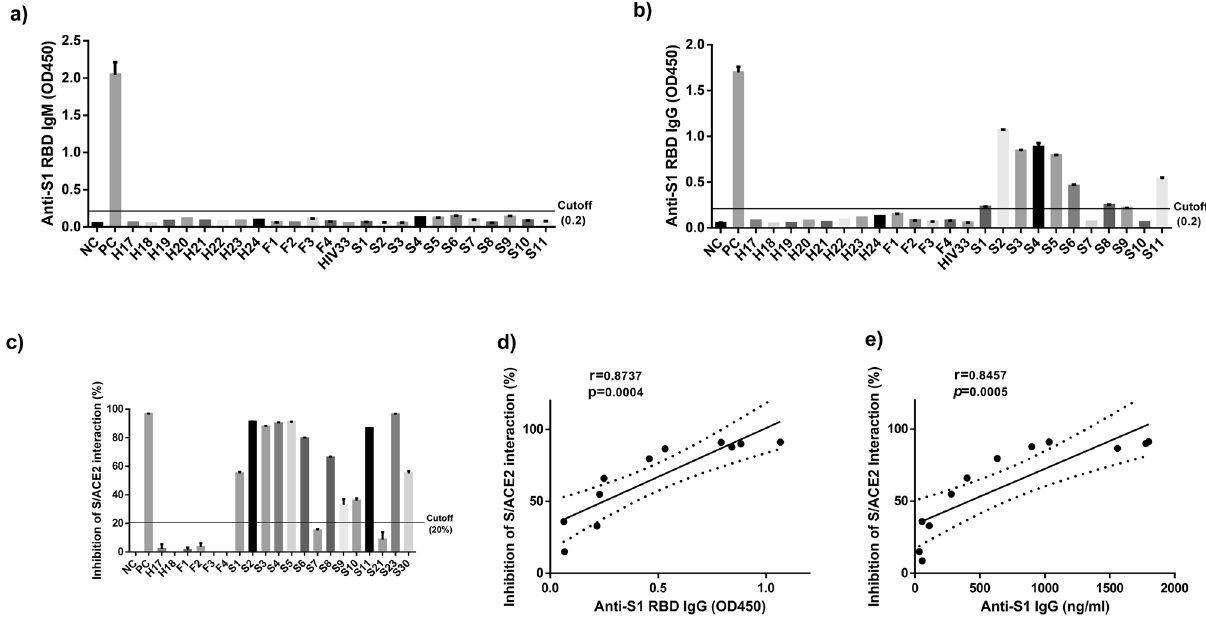
Figure 1. Detection of SARS-CoV-2 specific antibodies in the plasma of COVID-19-recovered subjects. ( a – b ) The IgM and IgG antibodies against SARS-CoV-2-S1 RBD were detected in the plasma of COVID-19-recovered subjects and control subjects by ELISA. ( c ) The NAbs that block the interactions of SARS-CoV-2-S1 RBD and hACE2 were determined by an ELISA Test kit. ( d – e ) The correlation between the inhibition extent of NAbs and OD450 values of anti-S1 RBD as well as anti-S1 IgG antibodies. All the graphs in 1 were created by Prism 6.01 software (https ://www.graph